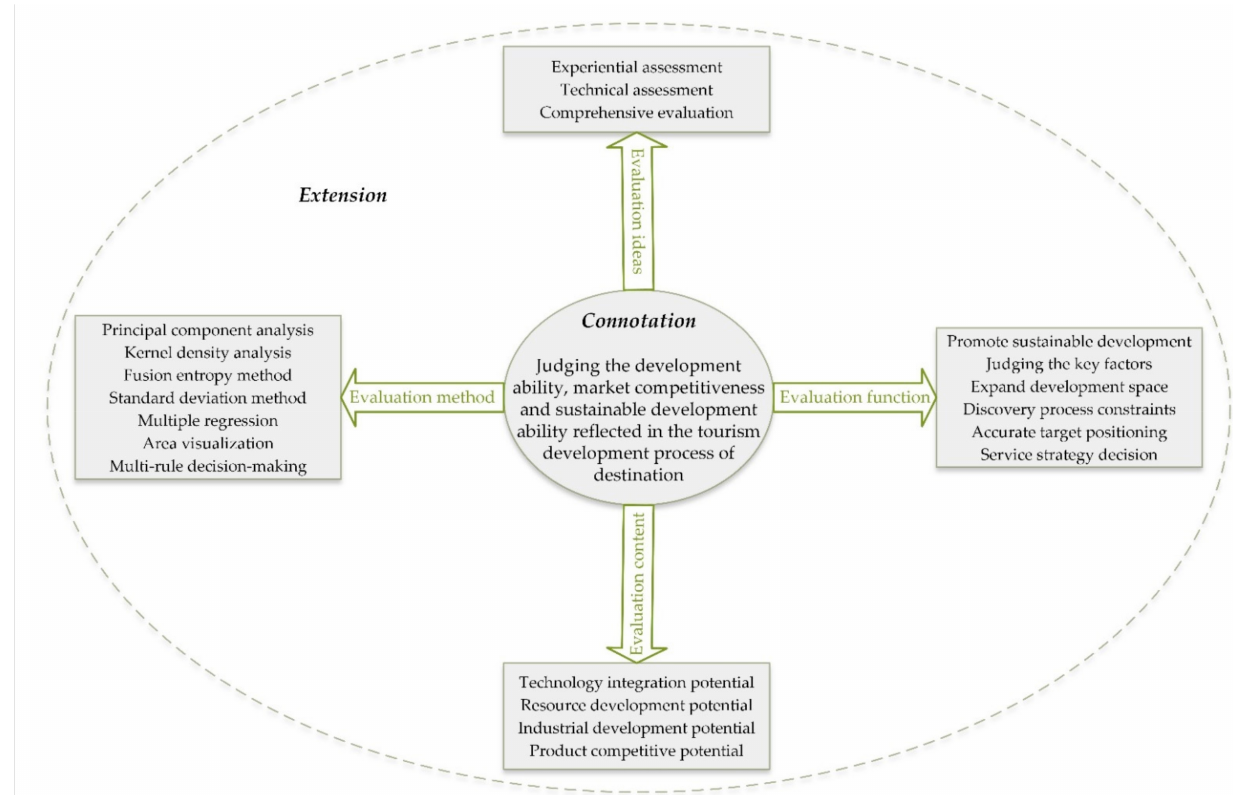
Figure 1. Conceptual cognitive model for evaluation of Destination